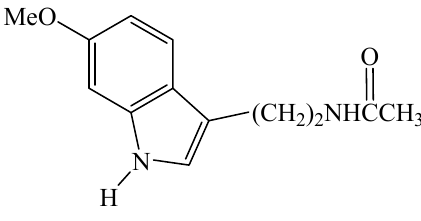
Figure 1. Structure of melatonin ( A ).